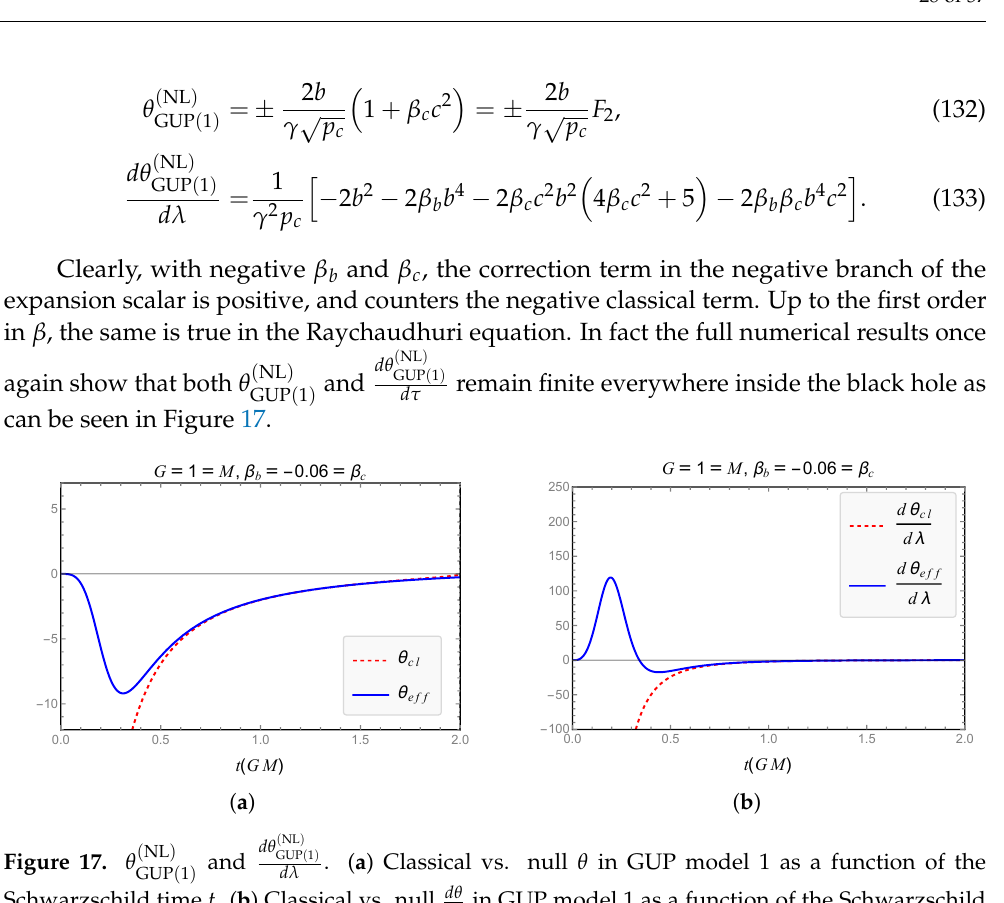
d θ ( NL ) ( NL ) GUP ( 1 ) Figure 17. θ and . ( a ) Classical vs. null θ in GUP model 1 as a function of the d λ GUP ( 1 ) Schwarzschild time t . ( b ) Classical vs. null d θ in GUP model 1 as a function of the Schwarzschild d τ ( NL ) time t . Both the effective expansion θ and its rate of change GUP ( 1 )